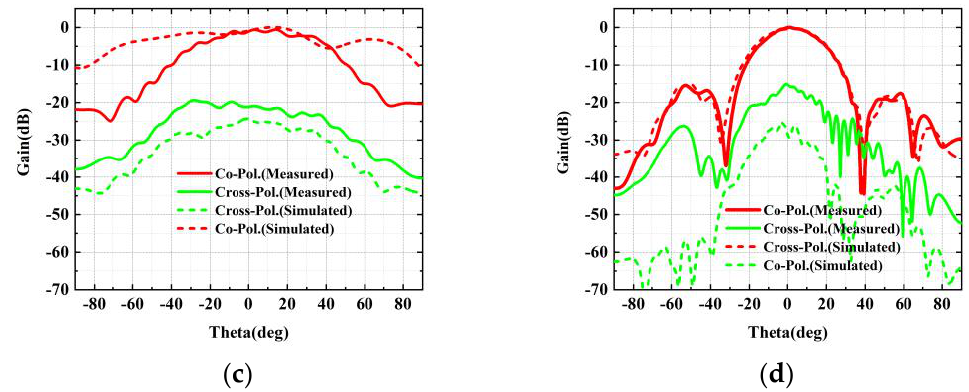
Figure 10. Patterns of the central 4×4 subarray of the proposed array. ( a ) E-plane at 4 GHz. ( b ) E-plane at 18 GHz. ( c ) H-plane at 4 GHz. ( d ) H-plane at 18 GHz. In addition, some differences in the cross-pol. Nulls were found between the measure- ment and simulation, which are mostly attributed to minor deviations introduced during